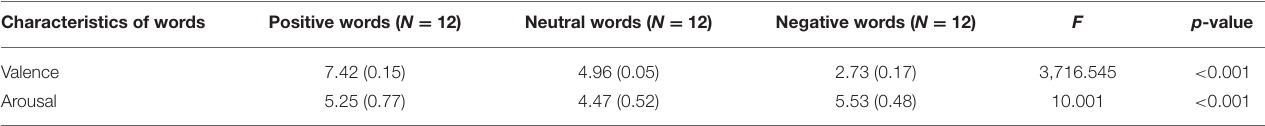
TABLE 2 | Univariate analysis of variance about the Valence and Arousal of the positive, neutral and negative words selected from Chinese Affective Words System (CAWS). Characteristics of